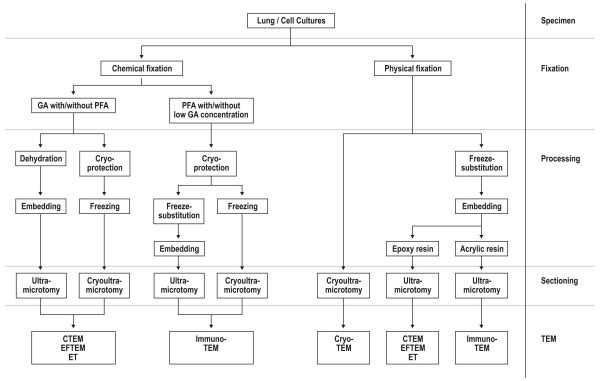
Survey on several transmission electron microscopy strategies. The figure provides help to chose a specific strategy for TEM preparation based on the scientific purpose of the study. It shows the crucial decisions in specimen preparation from the fixation level to the investigation at the TEM. Abbreviations: GA = glutaraldehyde; PFA = paraformaldehyde; CTEM = conventional TEM; EFTEM = energy-filtered TEM; ET = electron tomography.